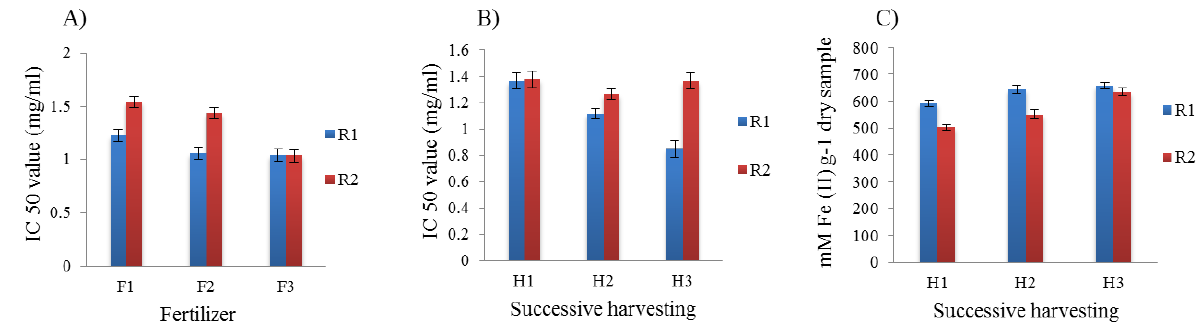
value; (B) Effect of fertilizer rate (R) and successive harvesting (H) on 50